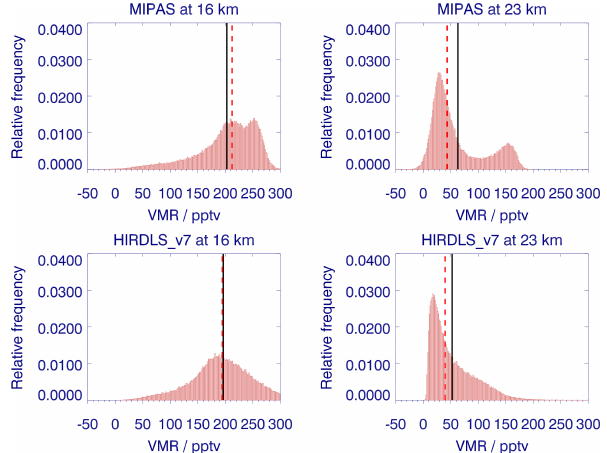
Figure 7. Histogram of collocated MIPAS CFC-11 measurements (top panels) and HIRDLS measurements (bottom panels) for the years of 2005–2008 at 16km (left panels) and 23km (right panels). The black line indicates the location of the mean of the sample, while the red dashed line marks the median.